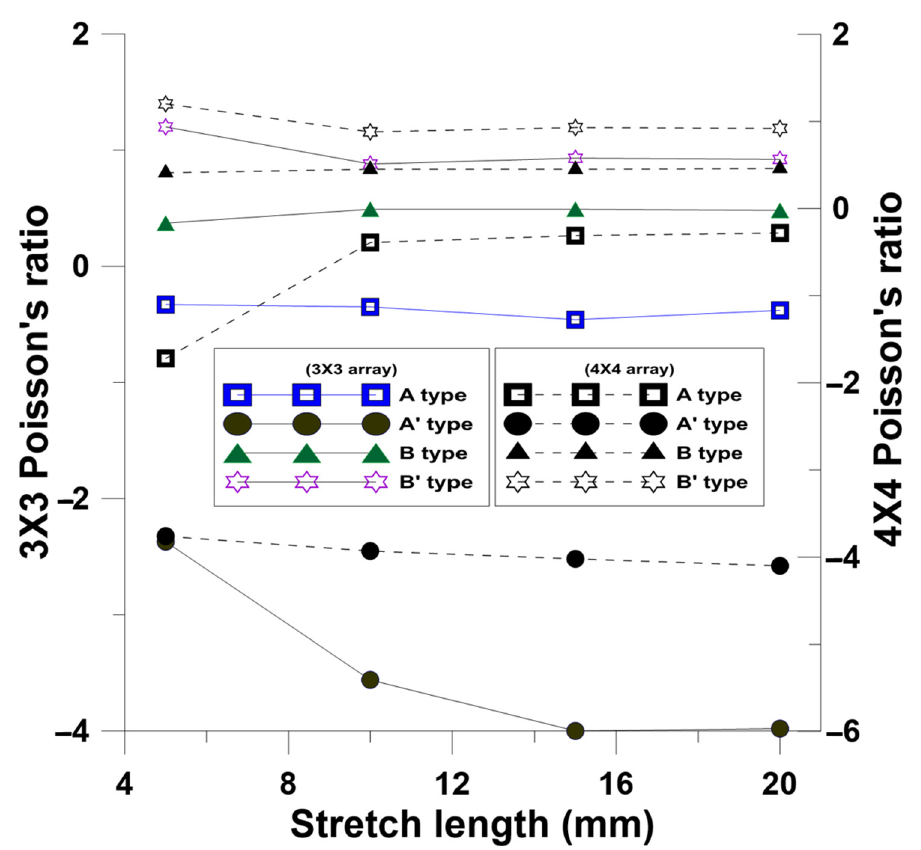
Figure 15. Poisson’s ratio changes of 3 × 3 and 4 × 4 NPR arrays at different stretching lengths.